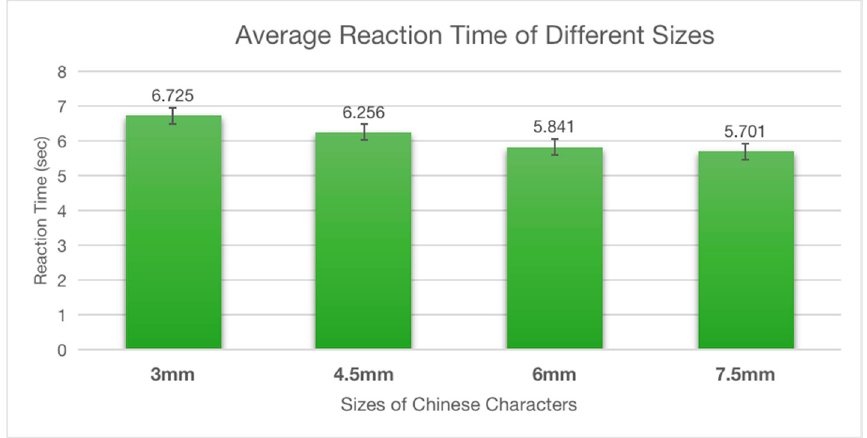
Figure 3. Average reaction time of Chinese characters’ different sizes.